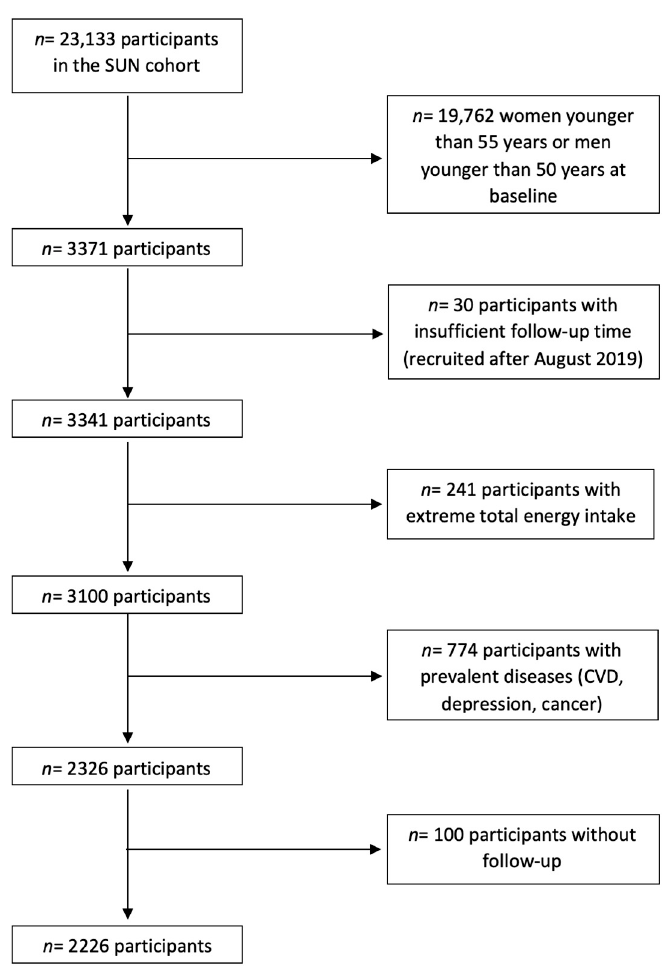
Figure 1. Flow chart of the participants in the “Seguimiento Universidad de Navarra” (SUN) project.